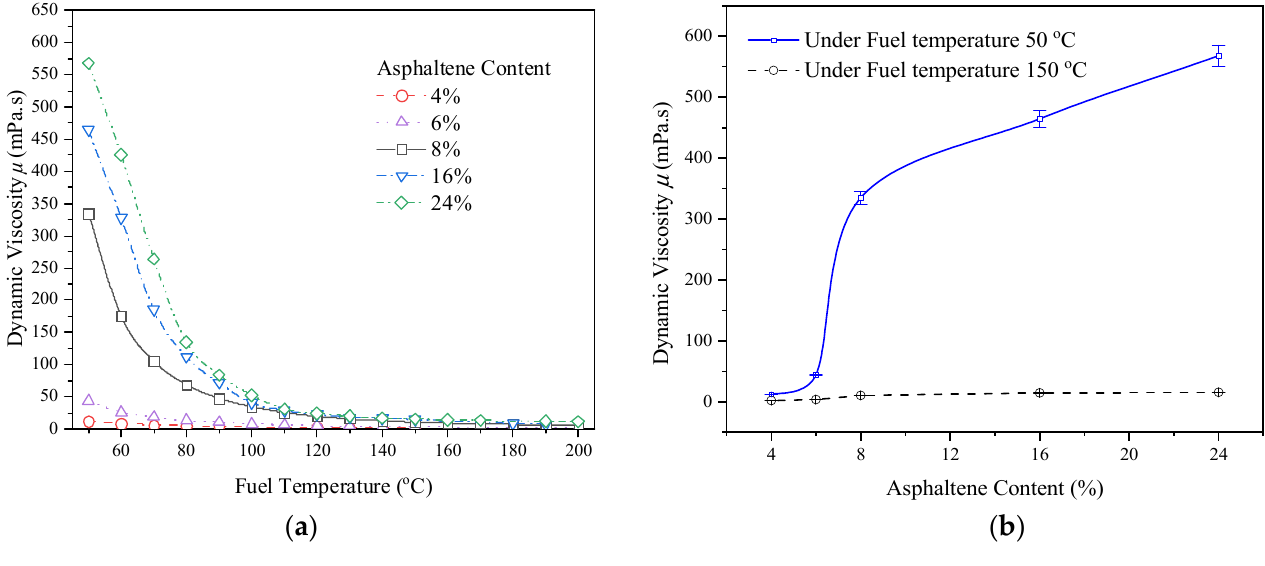
Figure 2. Viscosity distribution of different asphaltene contents of HFO with temperature. ( a ) With temperature variation. ( b ) Viscosity under 50 °C.